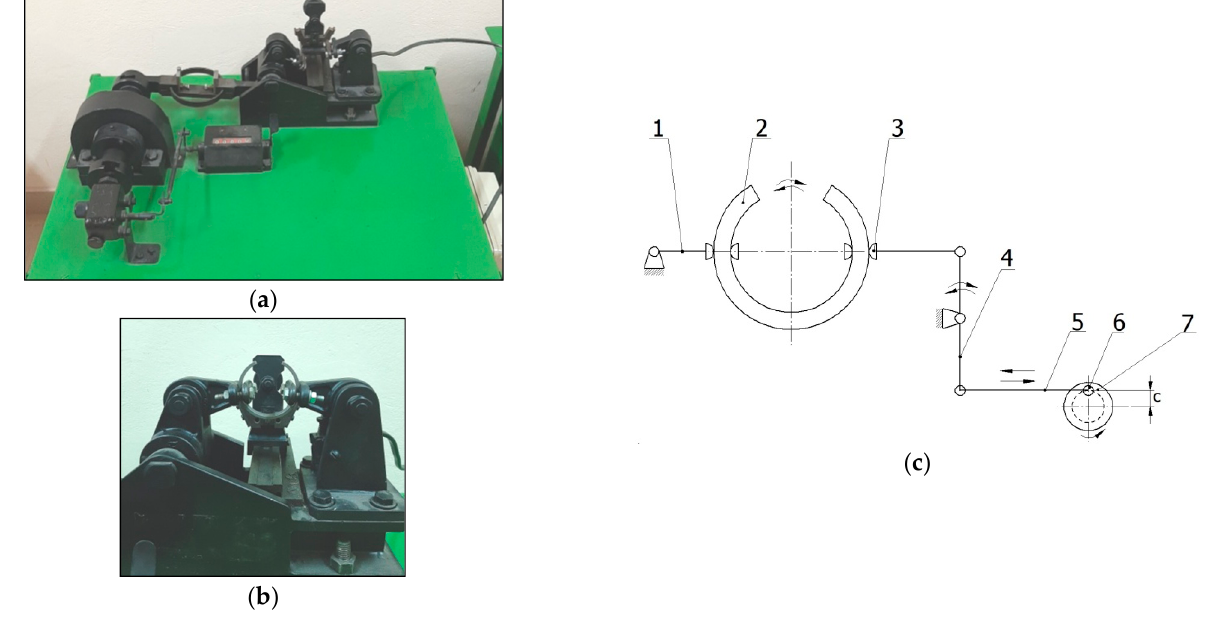
Figure 5. View of the test stand for fatigue life ( a ); mounted sample ( b ) and scheme of the test stand for fatigue life ( c ), where 1—fixed holder, 2—sample, 3—movable holder, 4—lever, 5—connecting rod, 6—mandrel, 7—disk.